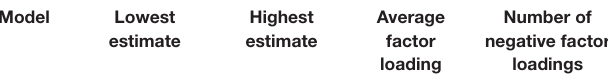
TABLE 4 | Summary of model parameters across models for parcels.